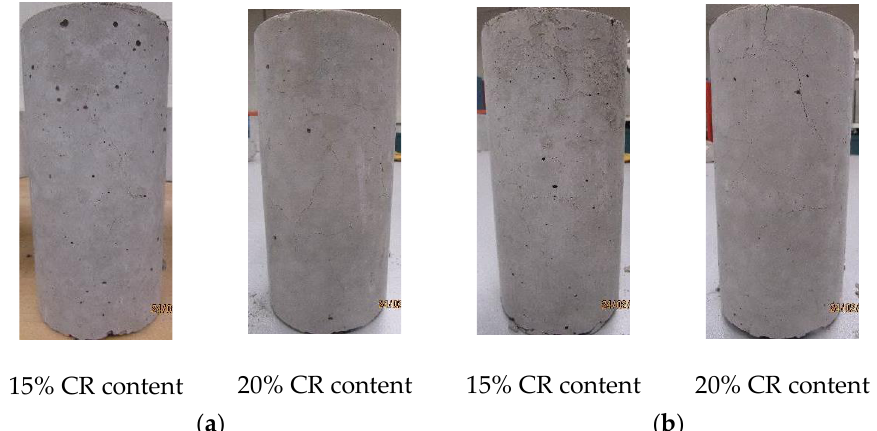
Figure 19. Serious damage to the concrete surface of specimens with 15% and 20% CR contents due to exposure to elevated temperatures of 121 °C and 260 °C. ( a ) For a temperature of 121 °C. ( b ) For a temperature of 260 °C.